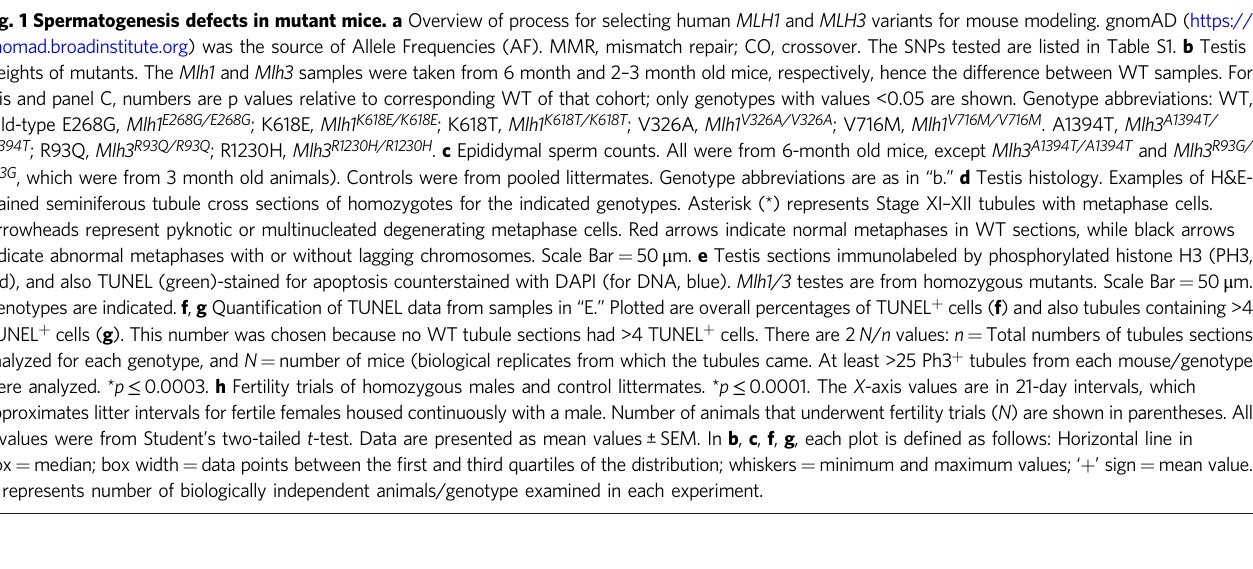
Table 1 SNPs modeled in mice.